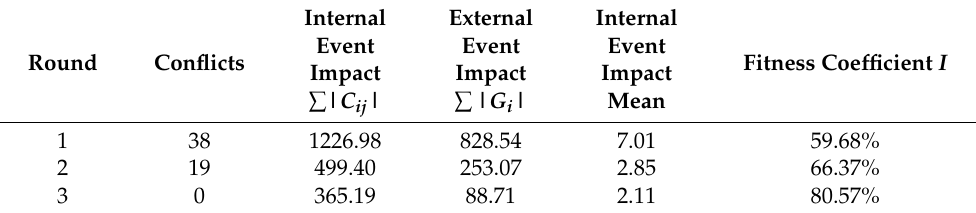
Table 5. Group estimation statistics table.